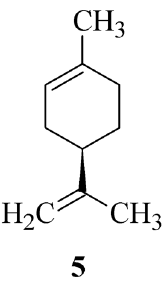
Figure 4 - Limonene ( 5 ), a natural product from citrus species.